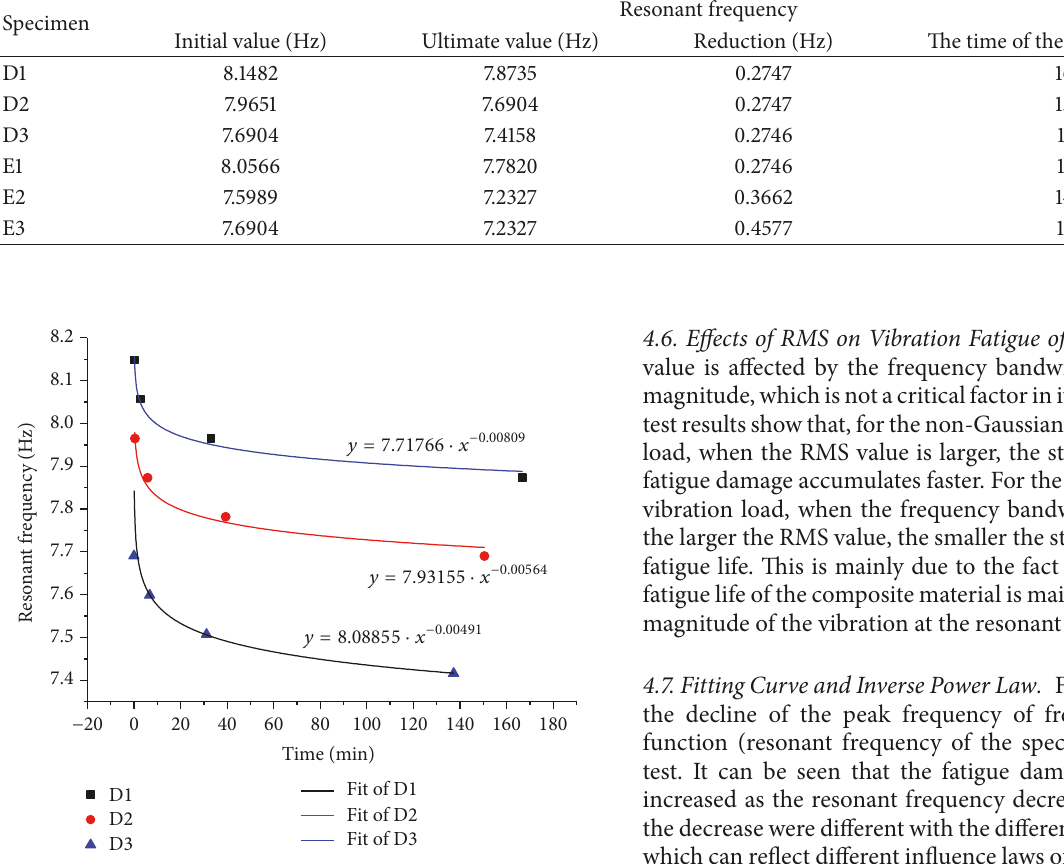
Figure 20: The variation and fitting curves of resonant frequency in Group D.